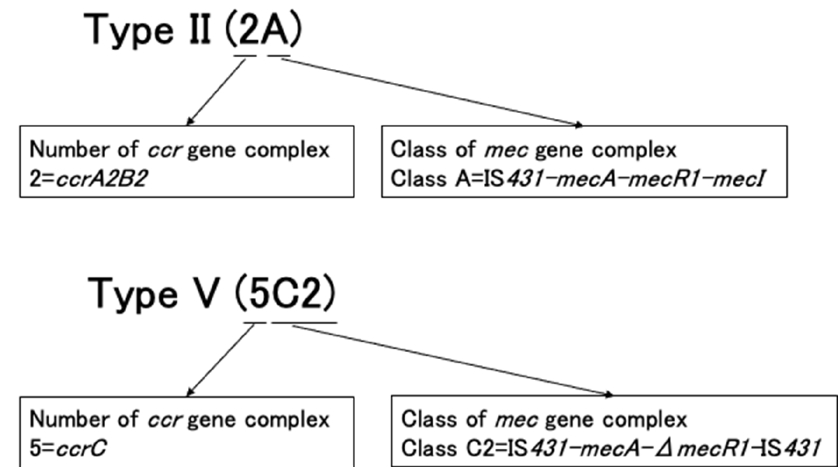
Figure 4. Description of SCC mec under two methods.